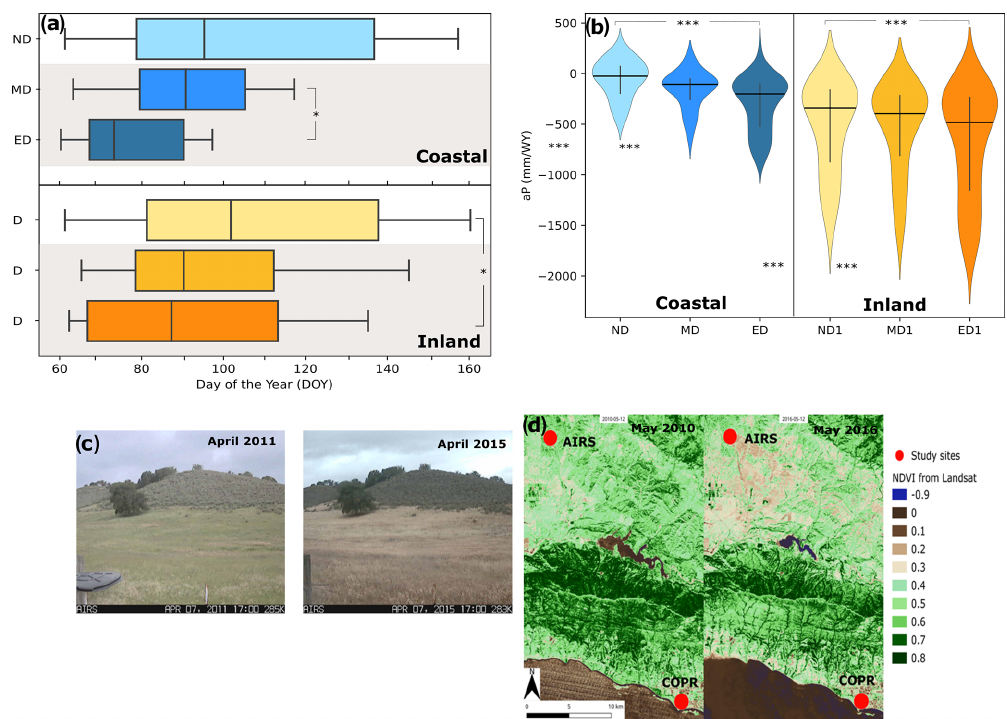
Figure 5. (a) The onset of the dry season for the coastal (blue hues) and inland (orange hues) sites, presented as day of the year (DOY). Ver- tical black lines indicate the median DOY, and whiskers indicate the maximum and minimum DOY recorded. (b) Violin plots of available P for a water year (October and September) for the non-drought (ND), moderate (MD), and extreme drought (ED) periods. Black horizontal lines indicate median aP and vertical lines the interquartile range. (c) Webcam images of the inland site during non-drought (April 2011) and extreme drought (April 2015) highlight the early onset and decline of greenness at the height of the drought. (d) Decline in greenness throughout Santa Barbara County seen through NDVI images. Statistical significance is indicated as p < 0 . 001 ( ∗∗∗ ) and p < 0 . 05 ( ∗